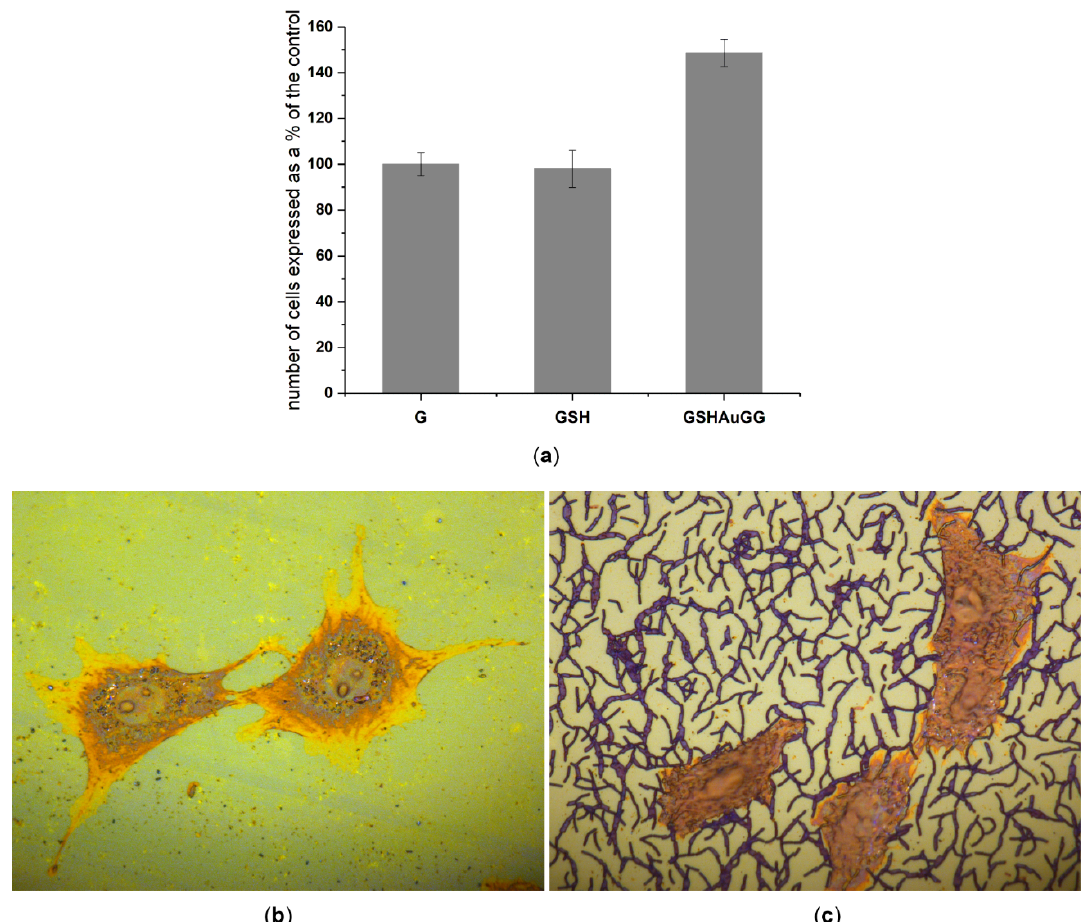
Figure 5. ( a ) Relative number of cells counted for glass (G), glass modified with –SH groups (GSH), and the final coating on the glass (GSHAuGG) substrates after crystal violet staining. Optical microscope images at 100× magnification of ( b ) Vero cells on the glass substrate (G) and ( c ) and on the GHSAuGG sample.